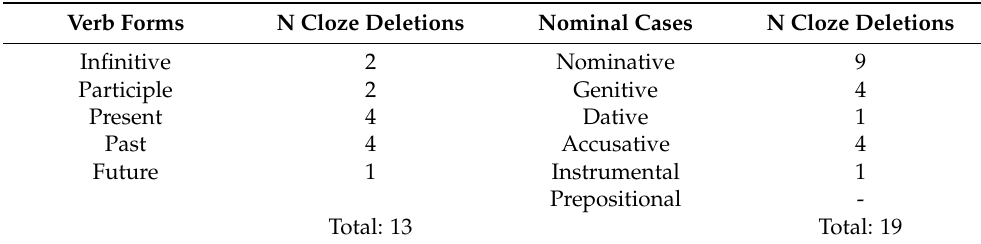
Table 3. Verb forms and morphological cases of nouns included among the deleted words.